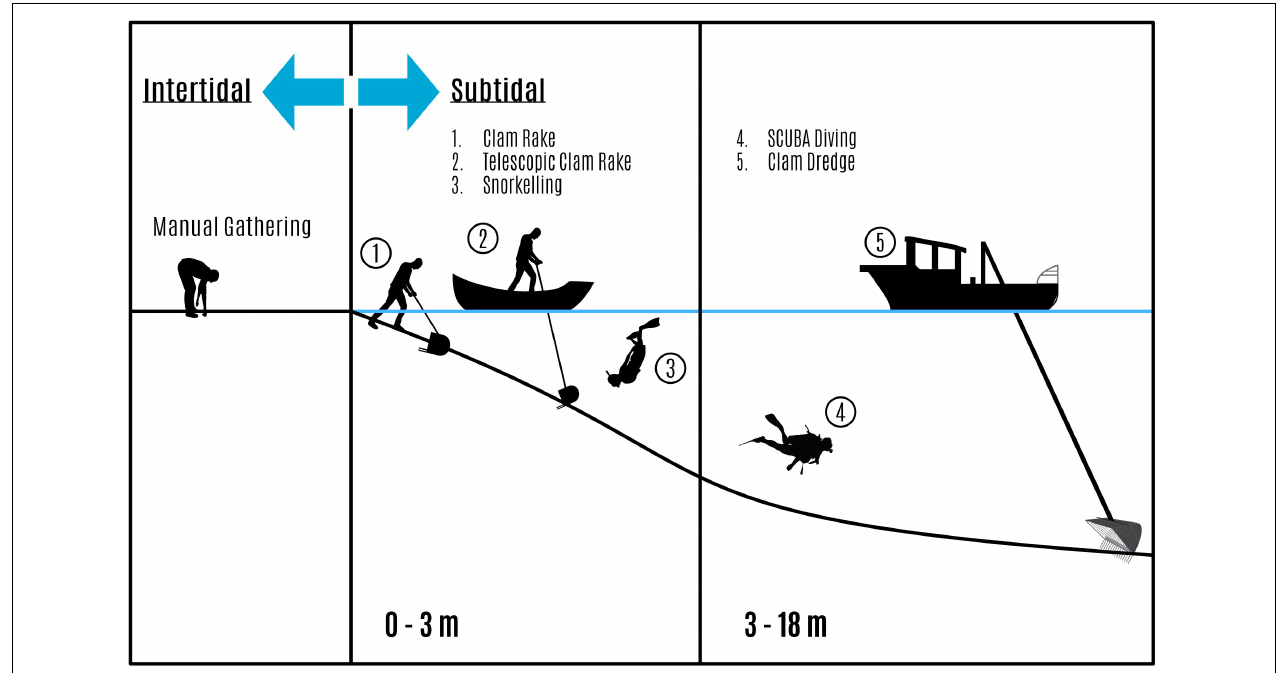
FIGURE 3 | Manila clam harvesting techniques depending on the depth (adapted from Ramajal et al., 2016).